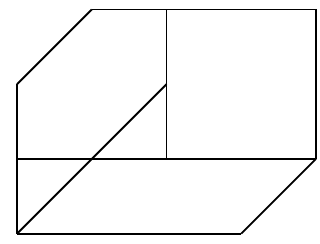
Figure 4 . An example of non-tight decomposition for diagonal quiver with m = 2.